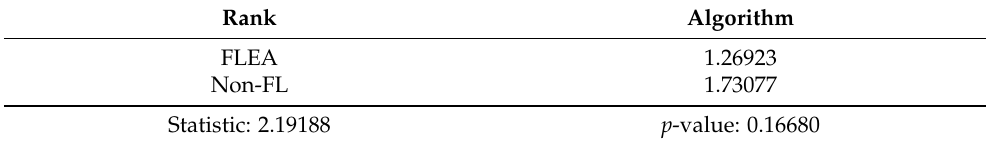
Table 9. Quade ranks test over the twelve subjects of the Ohio T1DM data set. Rank